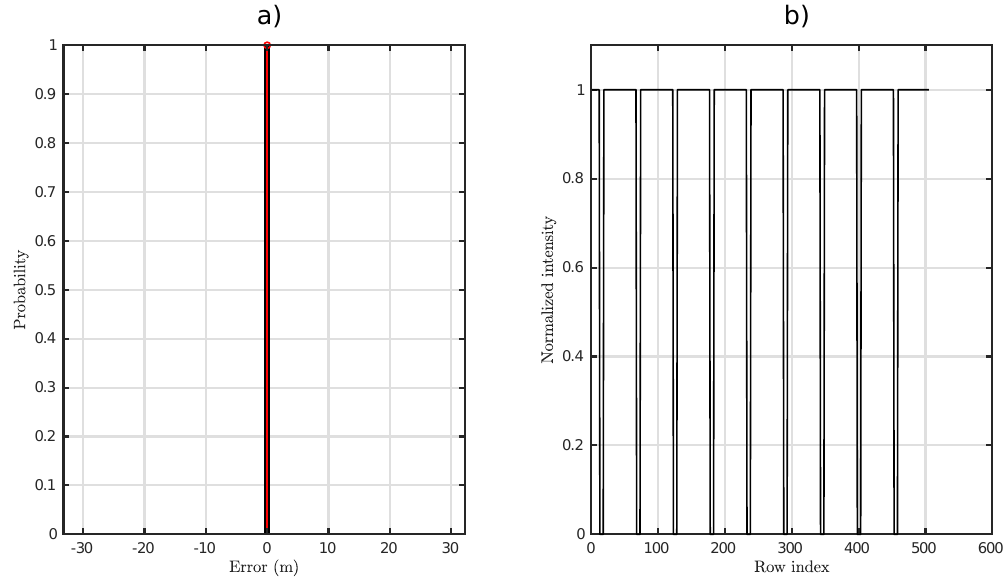
Figure 9. Empirical histogram in black versus theoretical result in red ( a ); and simulated signal within the corresponding ROI at 1 m ( b ). In total, 1024 independent simulations were